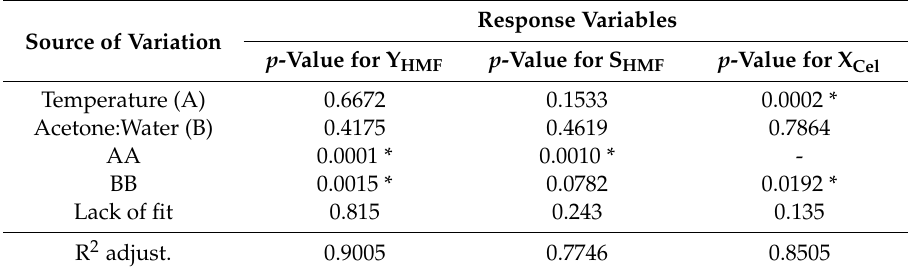
Table 4. Analysis of variance of estimated HMF yield (Y HMF ), HMF selectivity (S HMF ) and cellulose conversion (X Cel ) based on a central composite rotatable design